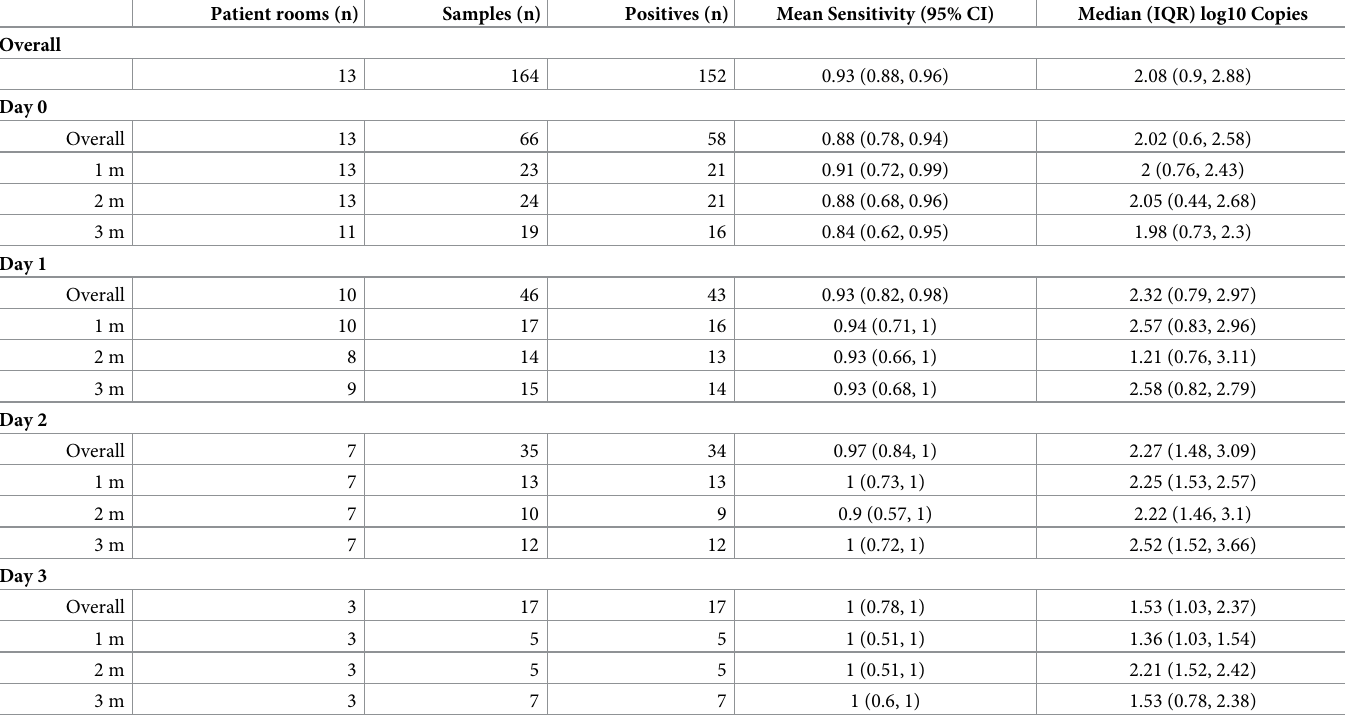
Table 1. Environmental detection of SARS-CoV-2 RNA in patient